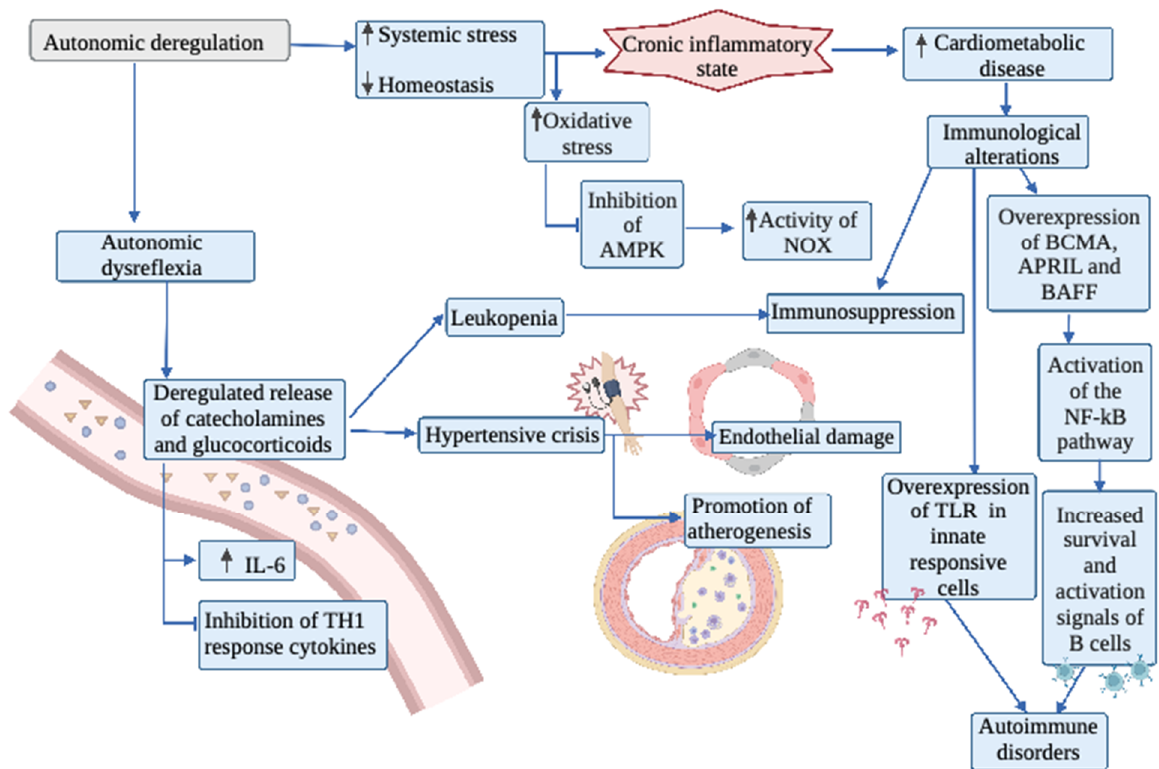
Figure 2. Overview of the role of inflammation and oxidative stress on the autonomic nervous system in patients with spinal cord injury. IL-6: Interleukin-6; AMPK: AMP-activated protein kinase; BCMA: B-cell maturation antigen; APRIL: A proliferation-inducing ligand; BAFF: B-cell–activating factor; NF-kB: Nuclear factor kappa B; TLR: Toll like receptors; NOX: NADPH oxidase.